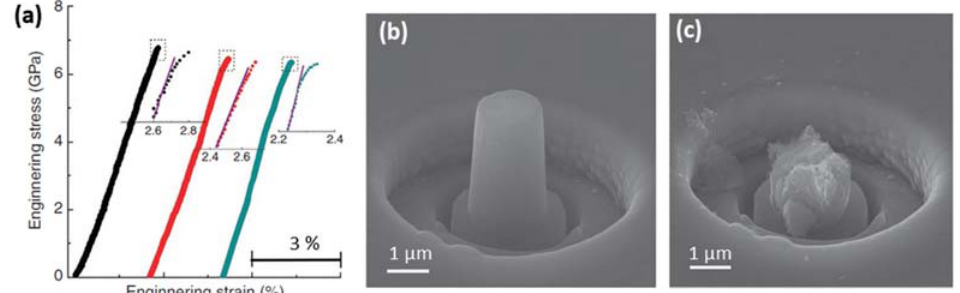
Figure 3. ( a ) Engineering stress–strain curve of n-B 4 C micropillars obtained by uniaxial micro-compression test (Colors of the curves correspond to the micropillar diameter of 1.6 µ m for black, 2 µ m for red, and 7 µ m for green). ( b ) SEM image showing fabricated n-B 4 C micropillar with a diameter of 1.6 µ m. ( c ) SEM image showing fractured n-B 4 C micropillar by intergranular mode. Reproduced with permission from [58]. Copyright 2022 Nature Communications.